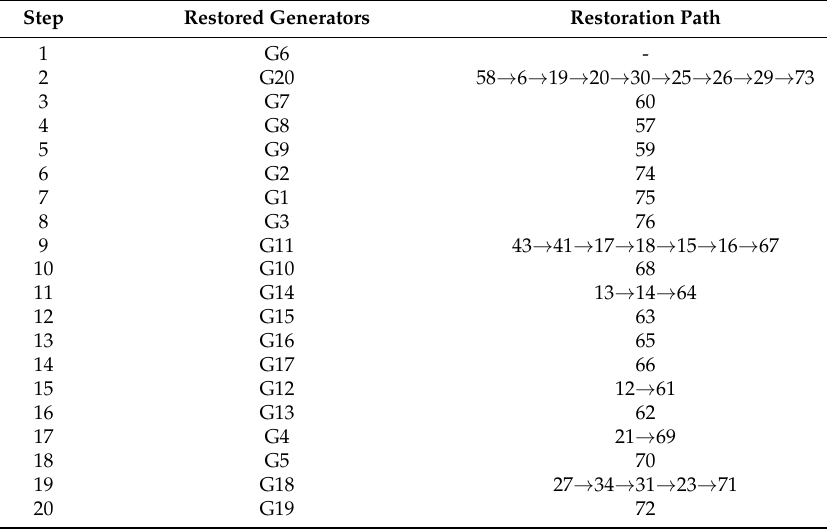
Table 3. The results of the simulation: The eastern